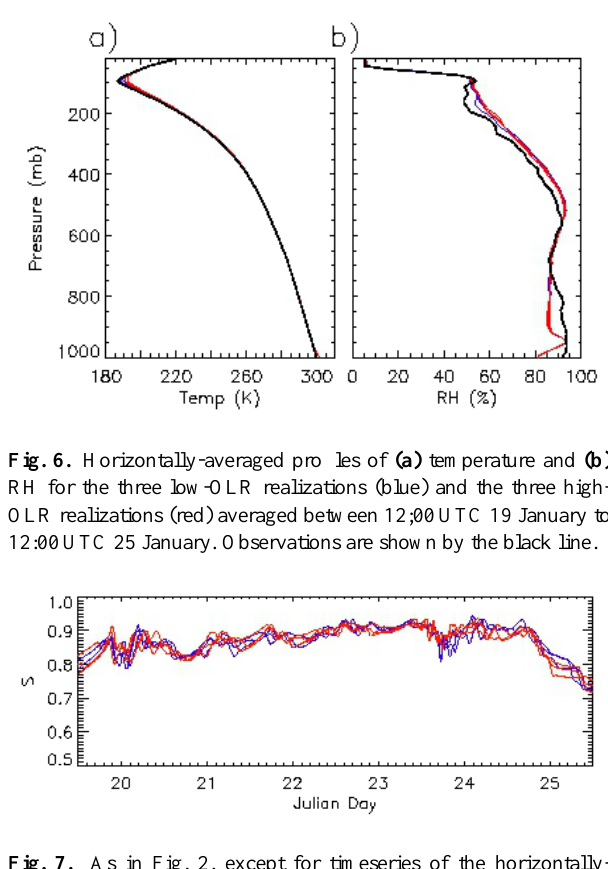
Fig. 7. As in Fig. 2, except for timeseries of the horizontally- average column saturation